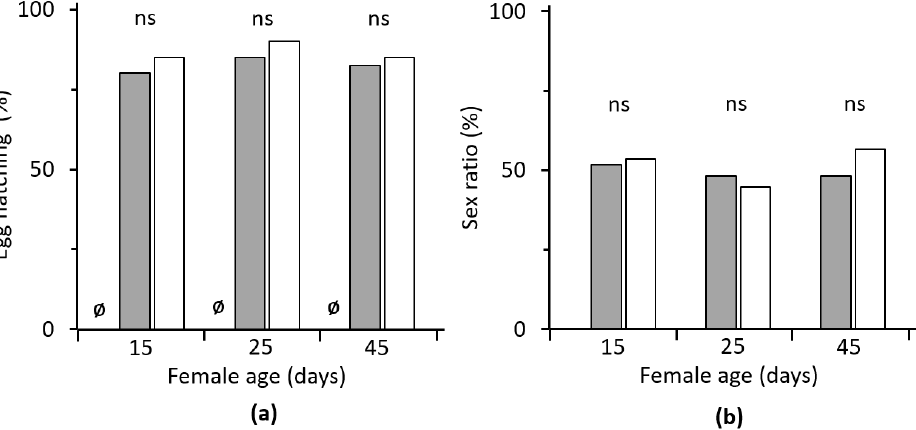
Figure 4 . ( a ) Hatchability of Chrysoperla agilis eggs laid by females of different ages ( n = 40) and ( b ) offspring sex ratio. Depending on the duration of male availability to females for mating, eggs were obtained by females that had the option of ( a ) 1 week mating: the male present for one week (gray bars, n = 29–31), or ( b ) lifetime: male present for the female’s lifetime (white bars, n = 28–30); χ 2 -test: ‘ns’ denotes no significant differences, and Ø denotes zero egg hatching for virgin females.